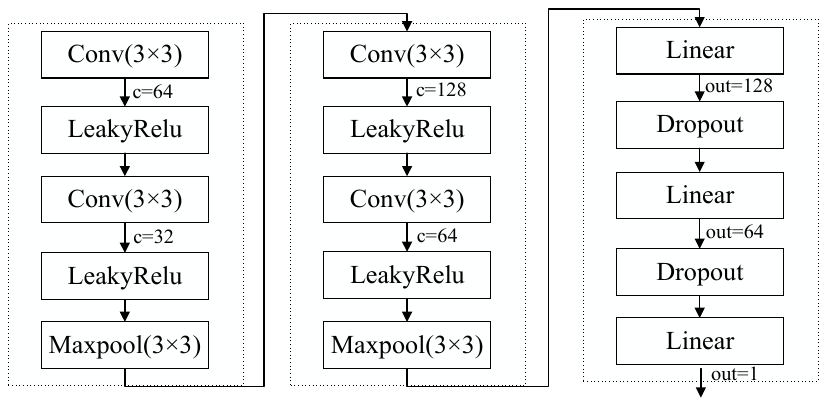
Figure 8. The baseline CNN architecture.